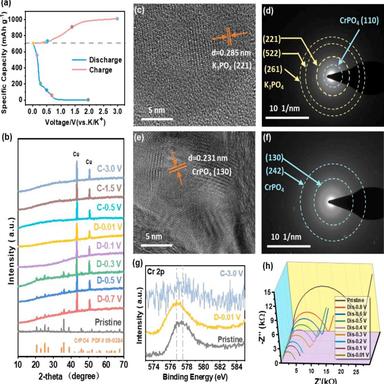
(a) Discharge–charge profiles for the first cycle of CrPO4@NC at 50 mA g− 1 , (b) the corresponding ex situ XRD patterns, (c) HRTEM images and (d) SAED pattern corresponding to discharge to 0.01 V, (e) HRTEM images and (f) SAED pattern corresponding to charge to 3.0 V, (g) Cr 2p XPS spectra of CrPO4@NC at various stages, (h) ex situ EIS curves at selected states of discharge process.